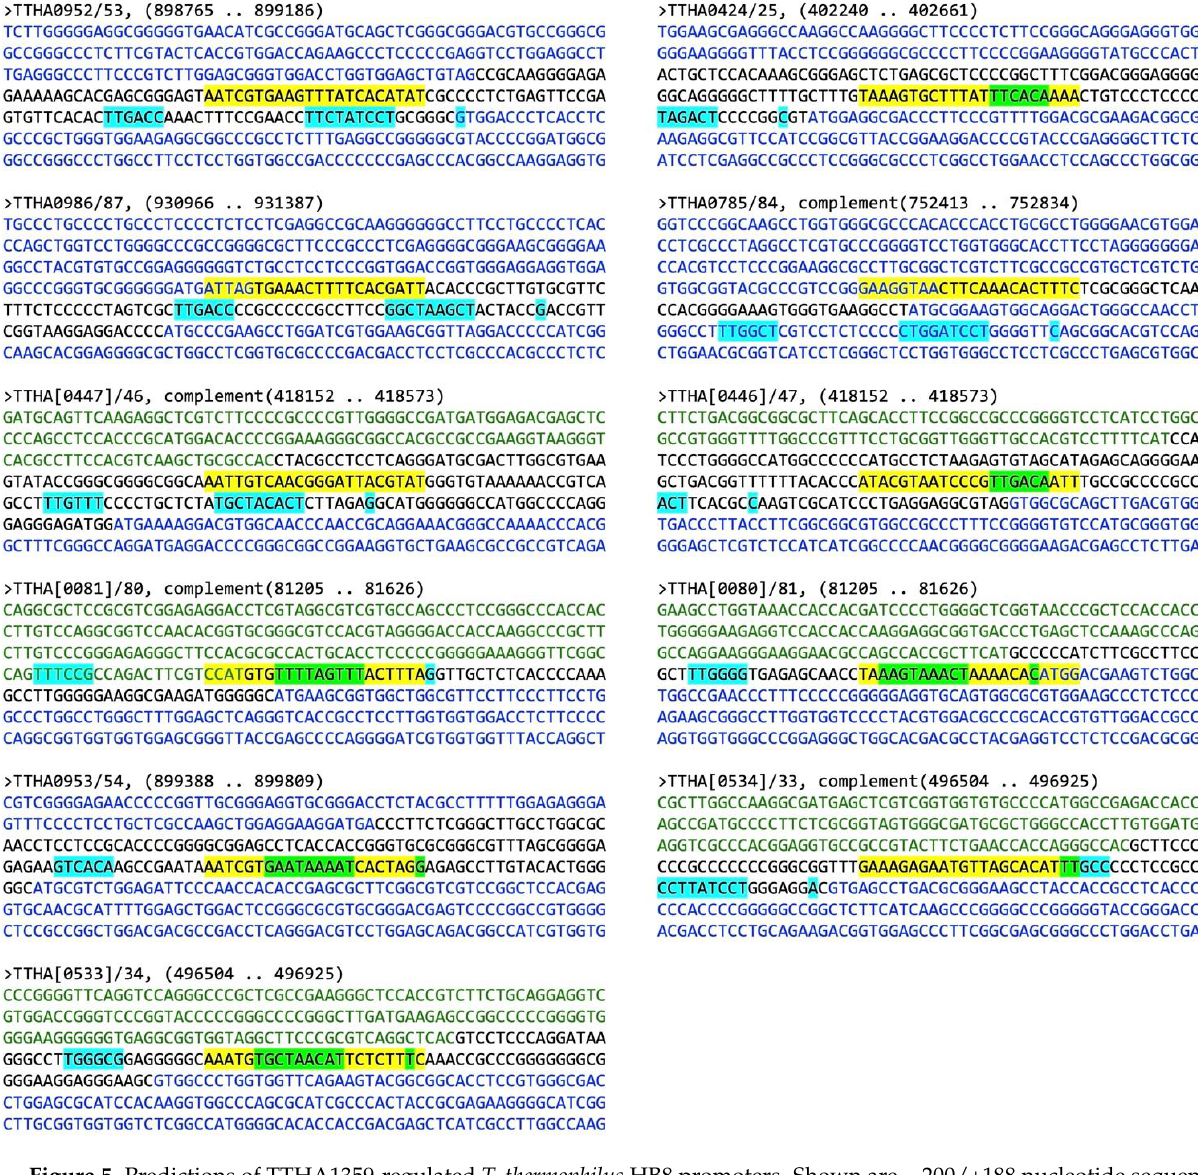
Figure 5. Predictions of TTHA1359-regulated T. thermophilus HB8 promoters. Shown are − 200/+188 nucleotide sequences surrounding the FIMO-identified TTHA1359 binding site (Table 2). Names indicate the pairs of ORFs shown. Default is with a rightward, downstream orientation and is indicated with blue nucleotides. Reverse orientation genes have their names in brackets and are indicated with green nucleotides. Black nucleotides indicate intergenic regions. Potential core promoter elements (–35 and –10 boxes, +1 start site of transcription) were predicted using Softberry BPROM [30] and are indicated with cyan highlighting; TTHA1359-binding sites are indicated with yellow highlighting; overlapping TTHA1359-binding and core promoter elements are indicated by green highlighting.